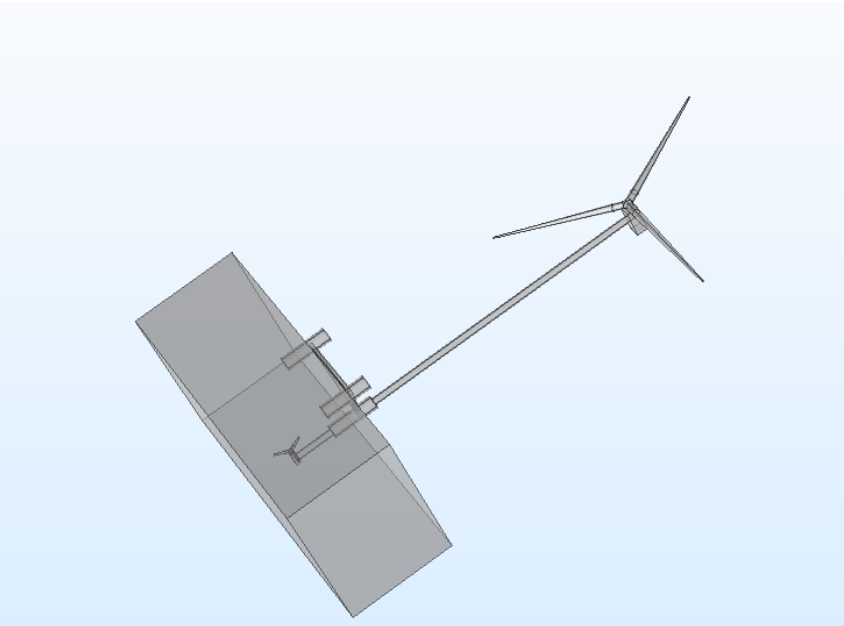
Figure 7. Water tunnel using the software. The concept of the following simulation is the same as the wind turbine simulation. The goal is to obtain v 2 to calculate the power generated by the tidal turbine, as presented in Figure 8.